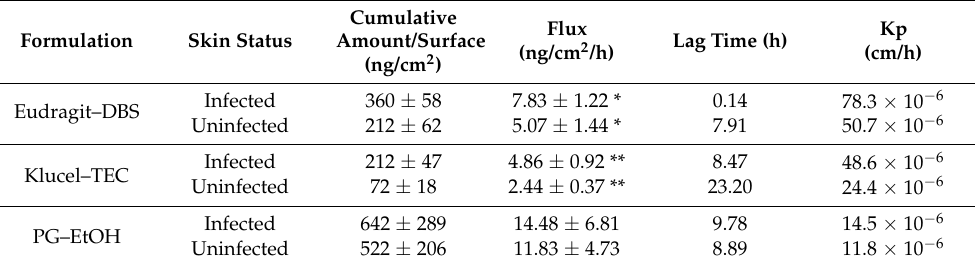
Figure 2. ( A ) Cumulative amount of DNDI-0690 permeated per surface are in time ( n = 4, average ± SEM), green and blue bracket for uninfected vs. infected skin for Klucel and Eudragit, respectively; black bracket Eudragit vs. Klucel for infected skin and Eudragit vs. Klucel for uninfected skin (* p < 0.05, repeated-measures ANOVA, post-hoc Tukey test, SPSS v26). ( B ) DNDI-0690 concentration present in 50 µ L skin homogenate ( n = 4, average ± SD) (* p < 0.05, one-way ANOVA, post-hoc Tukey test, SPSS v26). Table 4. Permeation parameters for DNDI-0690 when applied to Leishmania -infected or healthy BALB/c mouse skin (average ± SD, n =